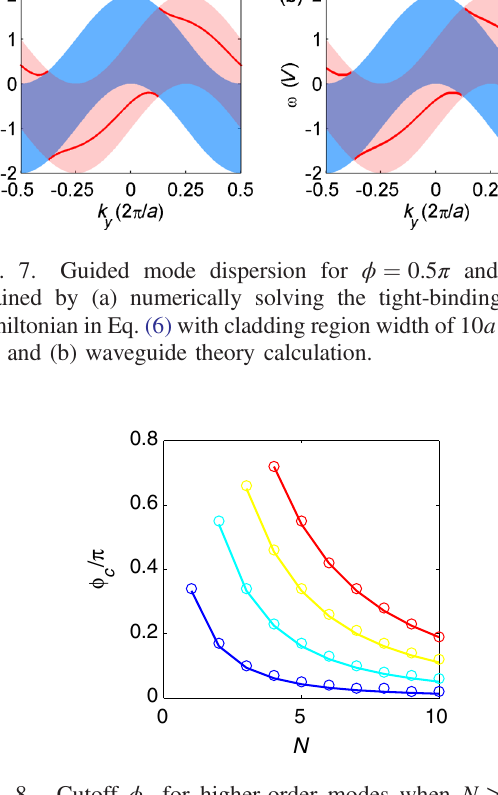
FIG. 8. Cutoff ϕ for higher-order modes when N ≥ 2 . The c mode order varies from s ¼ 2 (in blue) to s ¼ 5 (in red). Circles represent numerical results from tight-binding model. Curves represent analytical results from waveguide